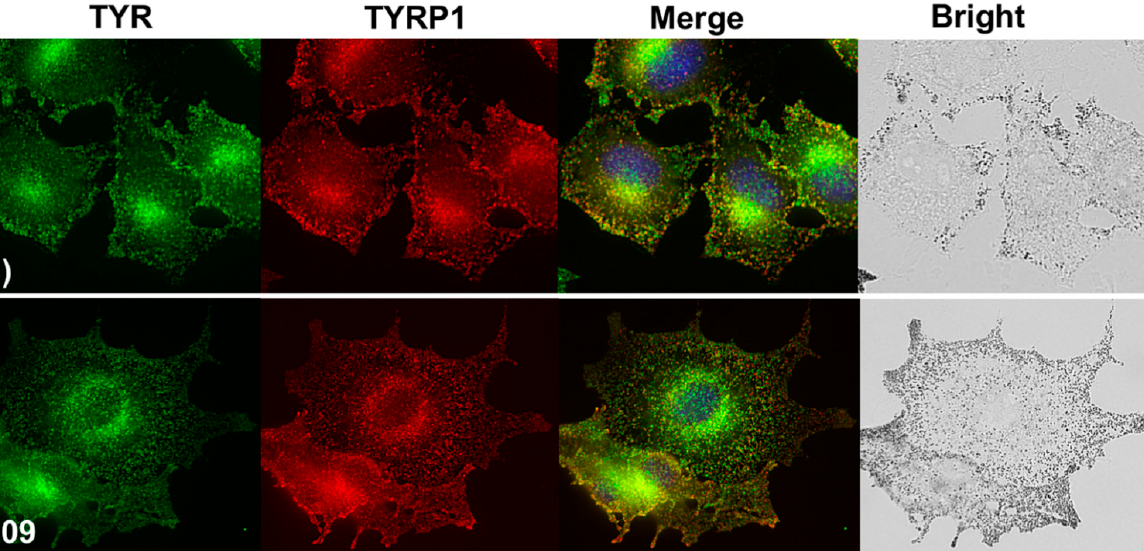
Figure 3. ( A ) B16F10 cells were treated with 10 µ M of GIF-2209 or GIF-2216 and 20 µ M Fsk for 24 h. The